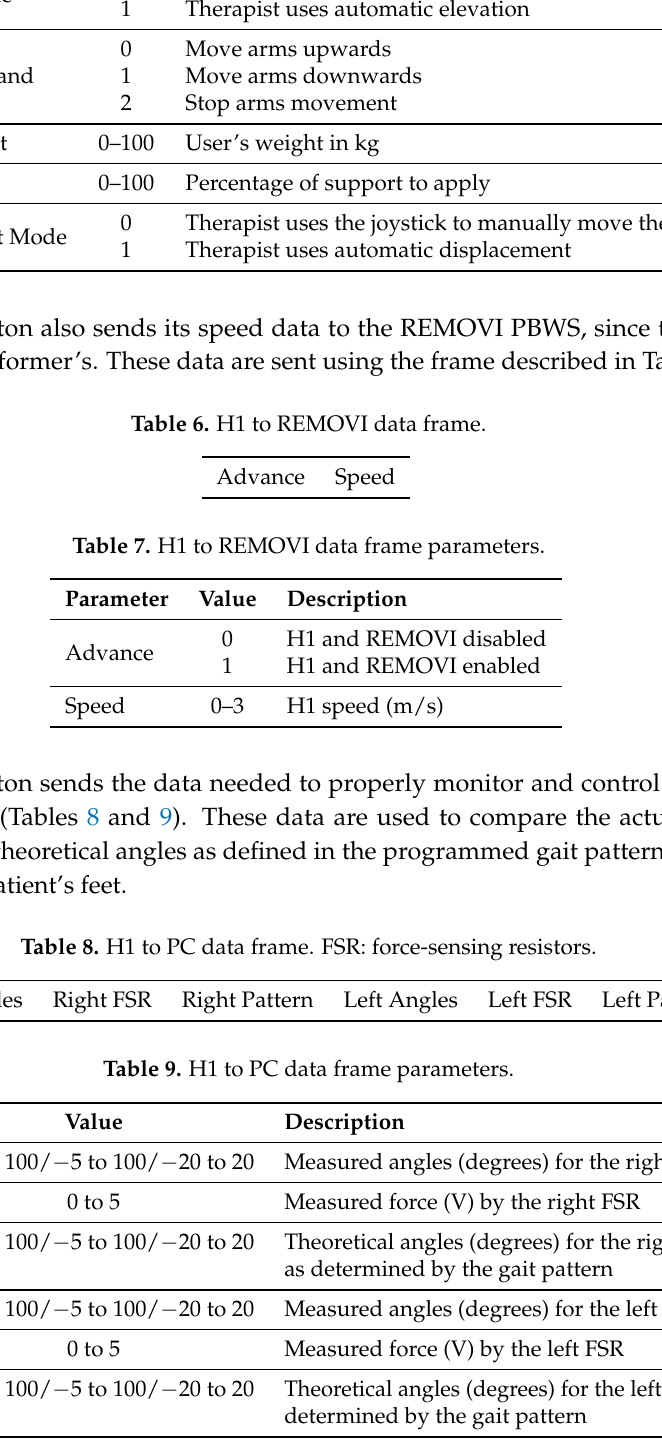
Table 5. REMOVI configuration frame parameters.